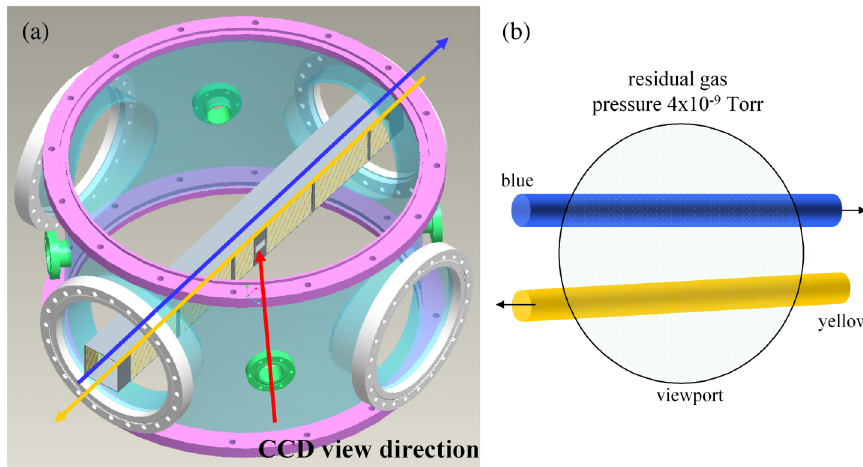
FIG. 1. (a) Drawing of the interaction chamber and the 45 (cid:4) viewing angle of the CCD. (b) Sketch of the ion beam image orientation showing the slight skew of the beam image as a result of the 45 (cid:4) viewing